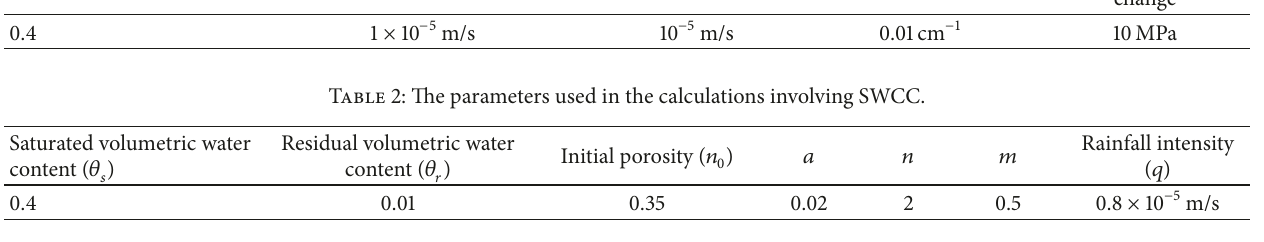
Table 3: The basic soil properties of an unsaturated porous medium.